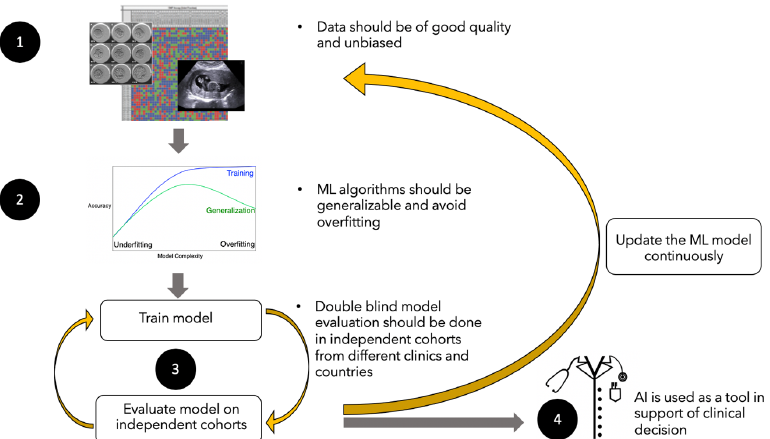
Figure 4. Challenges associated to the use of ML/AI algorithms. (1) Data should be labelled accurately and unbiased; (2) ML/AI algorithms should be generalisable and avoid overfitting; (3) Algorithms should be validated in independent cohorts and continuously updated; (4) Algorithms need to be translated and adopted into clinical practice.